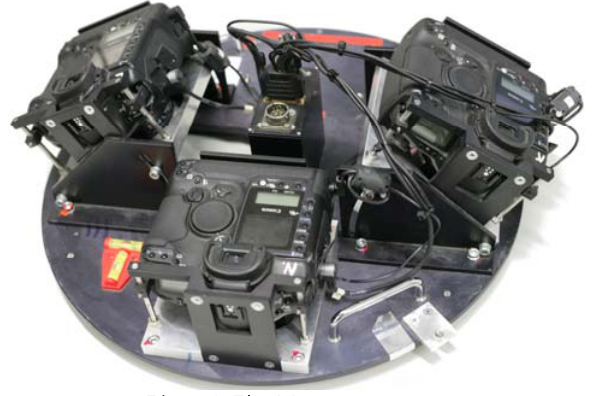
Figure 1. The 3K+ camera system